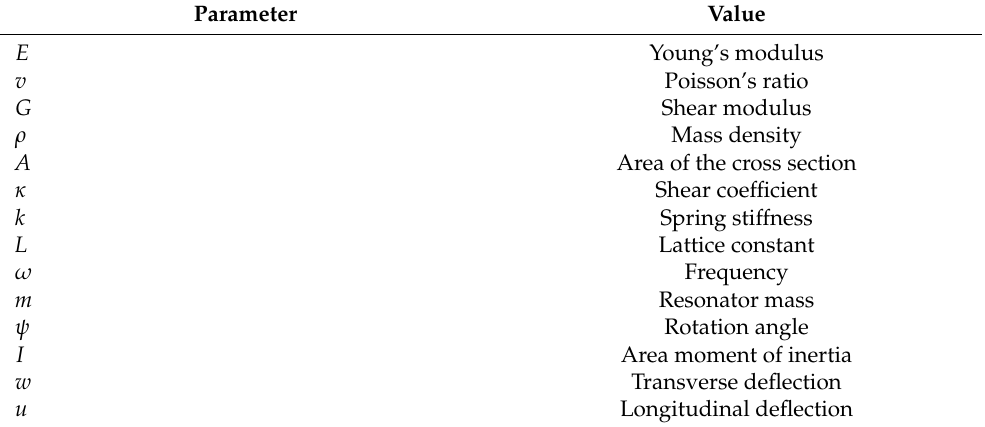
Table 1. Notations and definitions.